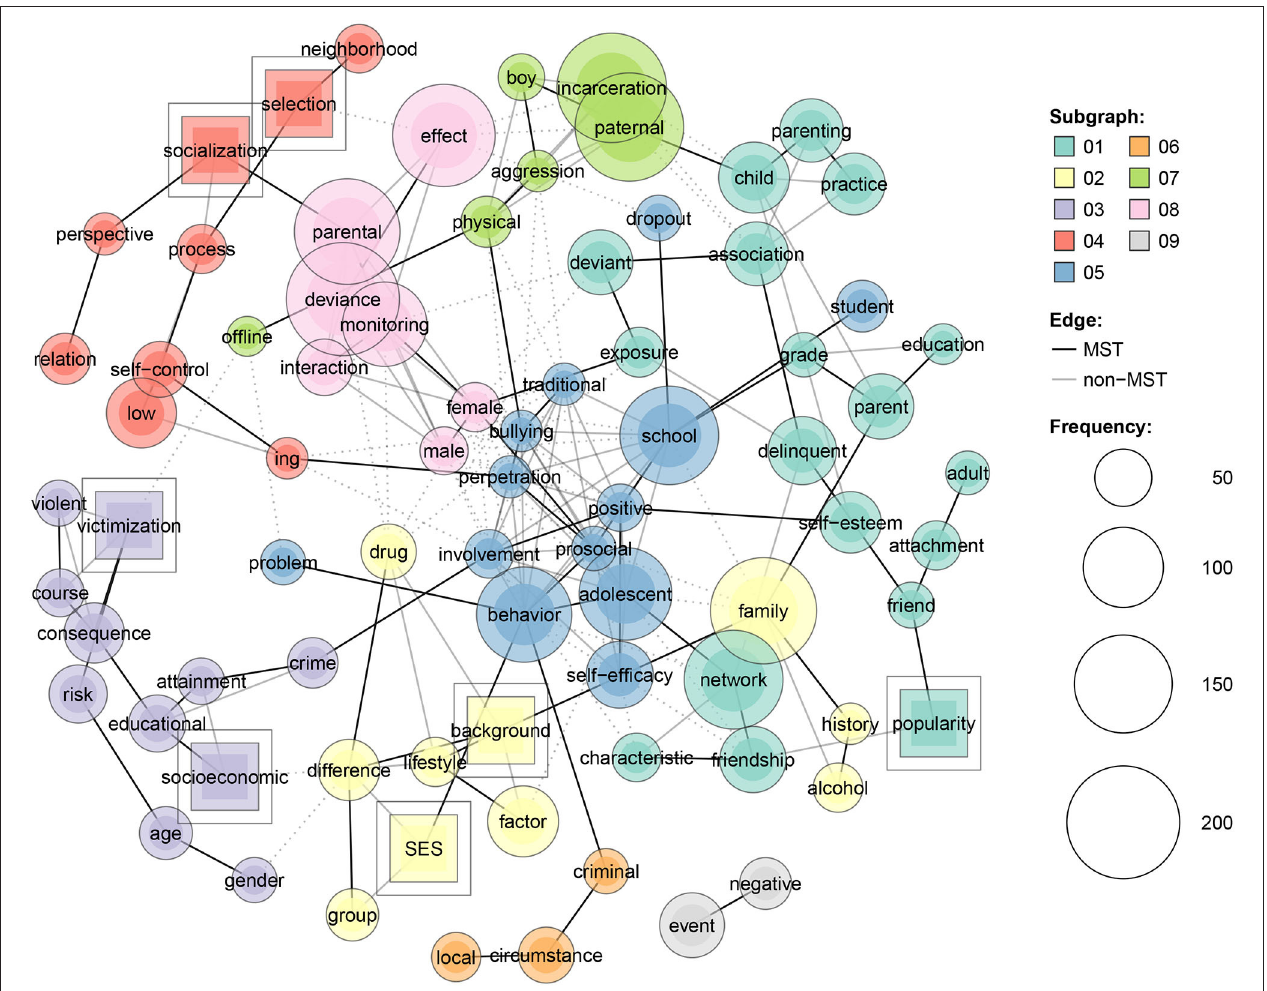
FIGURE 8 | Predictors of deviance grounded on modularity